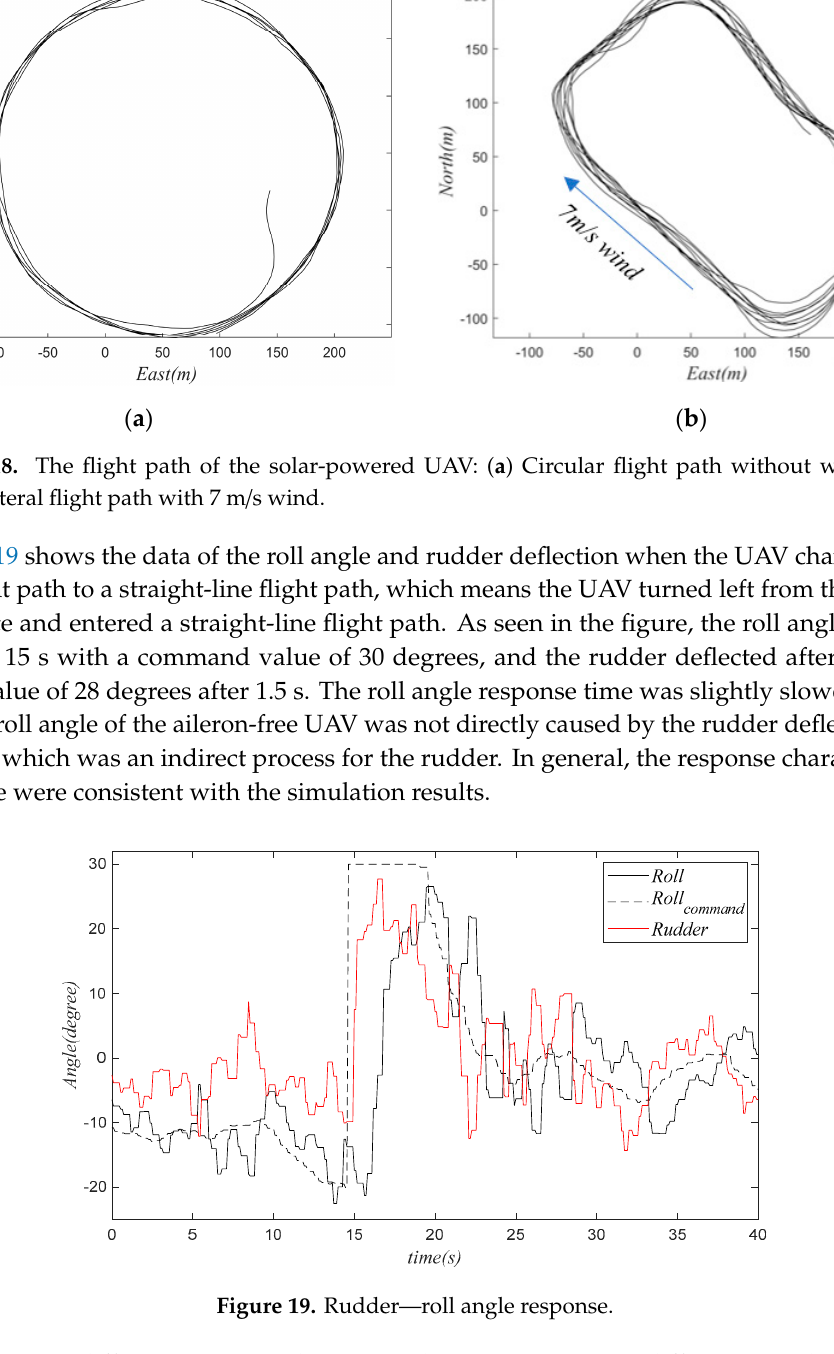
Figure 19. Rudder—roll angle response.